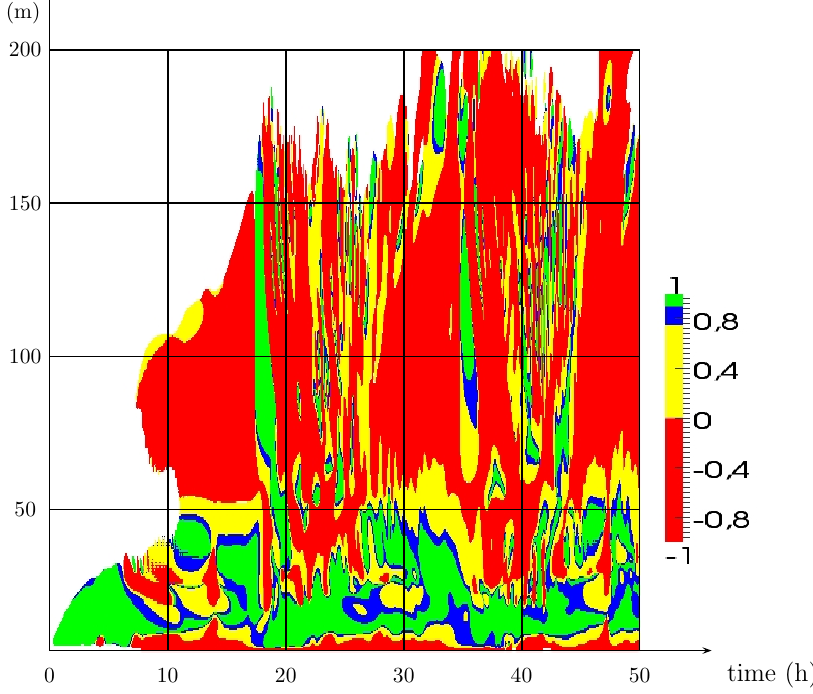
Fig. 11. Cosine c of the angle between the shear in the z-direction of the velocity vector in the x-y-plane and the flux in the z-direction of the momentum in the x-y-plane (as defined in Eq.